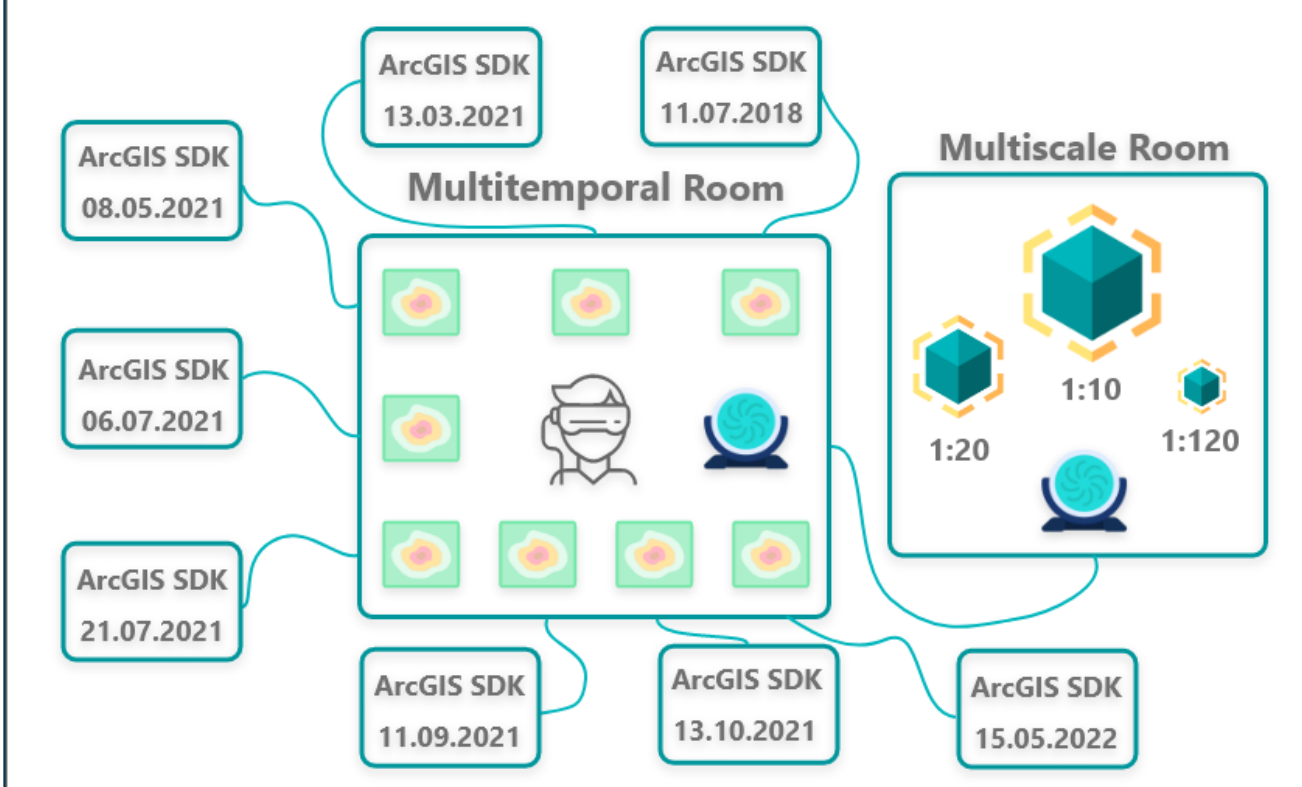
Figure 7. Structure of rooms/scenes in the VR